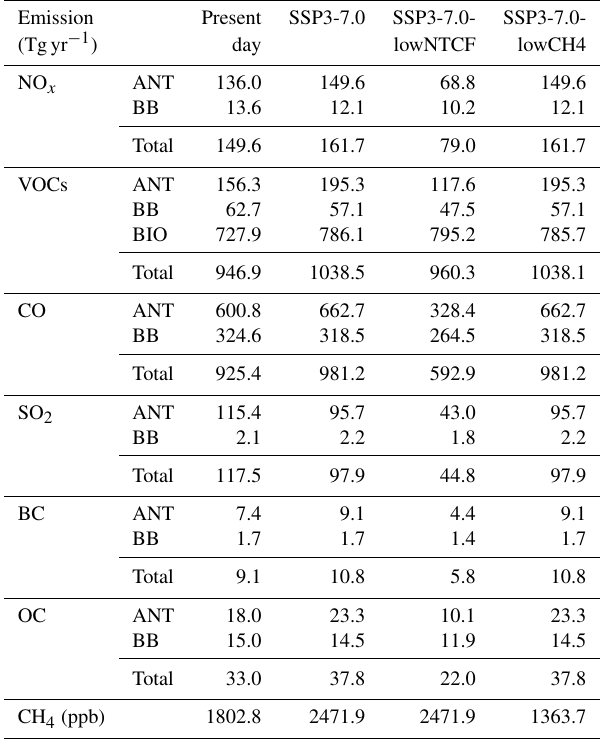
Table 2. Overview of global annual mean time-varying surface emissions of NO x , VOCs, CO, sulfur dioxide (SO 2 ), black car- bon (BC), and organic carbon (OC) from anthropogenic (ANT), biomass burning (BB), and biogenic (BIO) sources for the present day (2004–2014) and future (2045–2055) SSP3-7.0, SSP3-7.0- lowNTCF, and SSP3-7.0-lowCH4. Annual mean surface CH 4 mix- ing ratios (ppb) are also